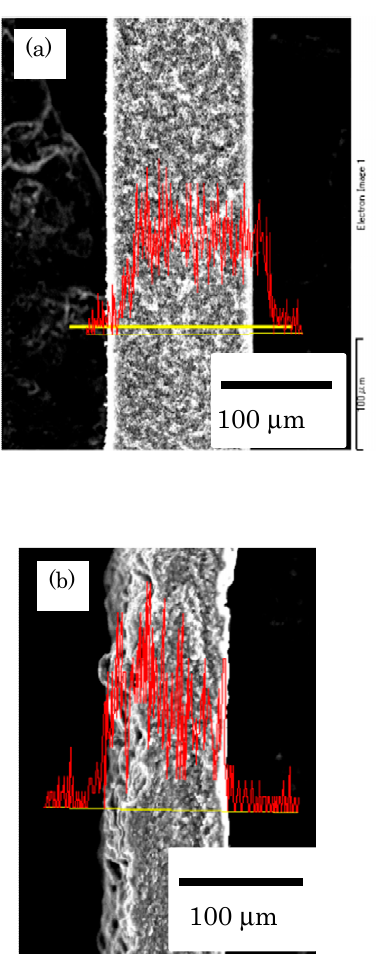
Figure 4. SEM micrographs of EDS analysis of cupper in the perpendicular direction of AAc-graft-PVDF: ( a ) before and ( b ) after compression treatment, respectively.